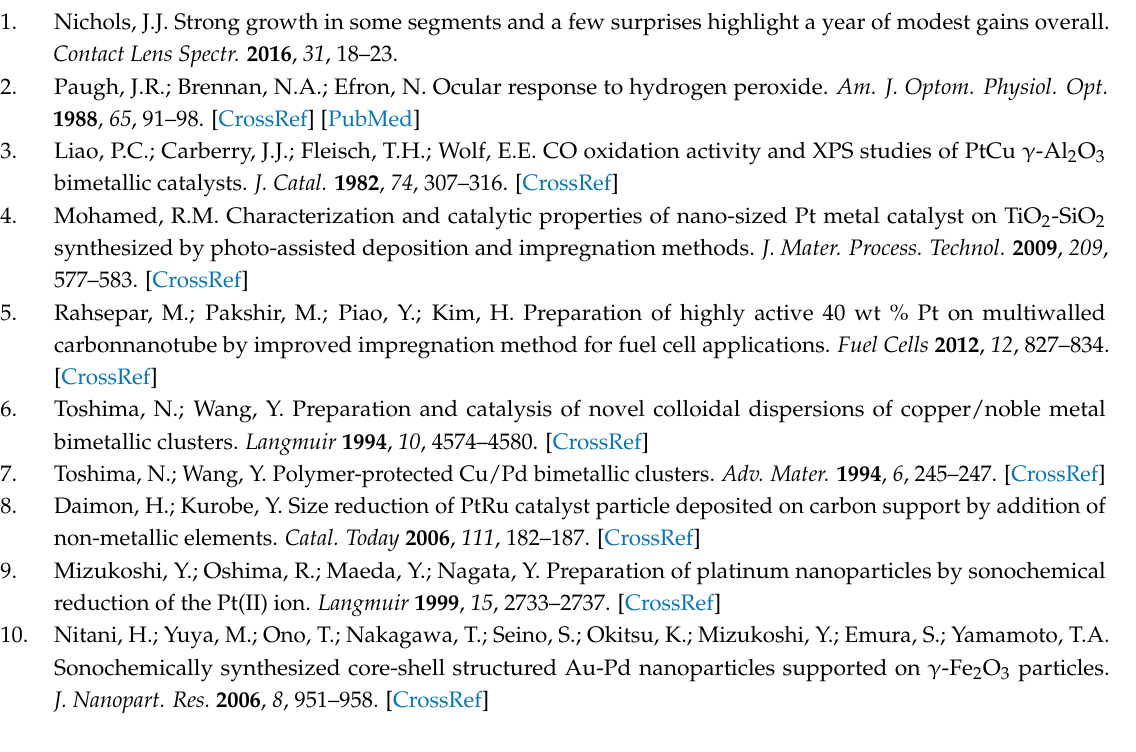
Figure S1: Calibration curve for calculating the amounts of Pt on the Pt-particle/ABS samples: relation between Pt concentration and emission intensity; Figure S2: Photographs of the coloration of peroxotitanium complex: relation between H 2 O 2 concentration and the color of peroxotitanium complex; and Figure S3: Calibration curve for calculating the H 2 O 2 concentration: relation between H 2 O 2 concentration and absorbance at 407